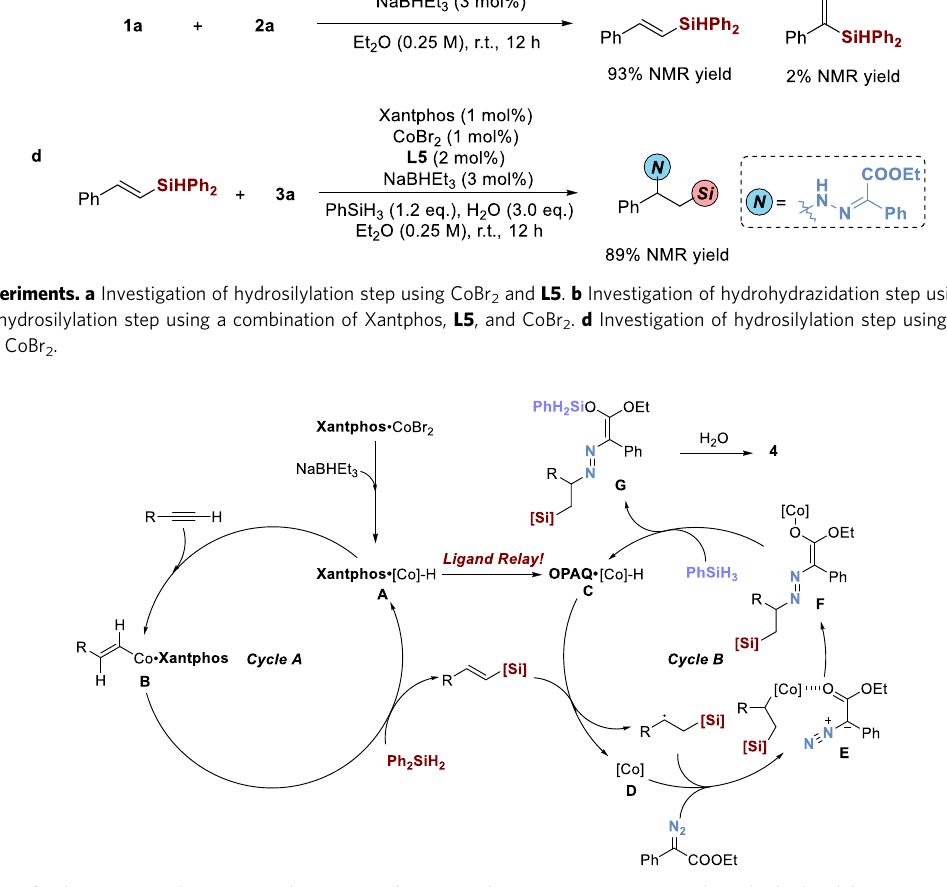
Fig. 10 Proposed mechanism. Proposed reaction pathway starts from Xantphos (cid:129) Co-H species to catalyze the hydrosilylation step, followed by the key ligand relay process to generate the OPAQ (cid:129) Co-H to catalyze the hydrohydrazidation